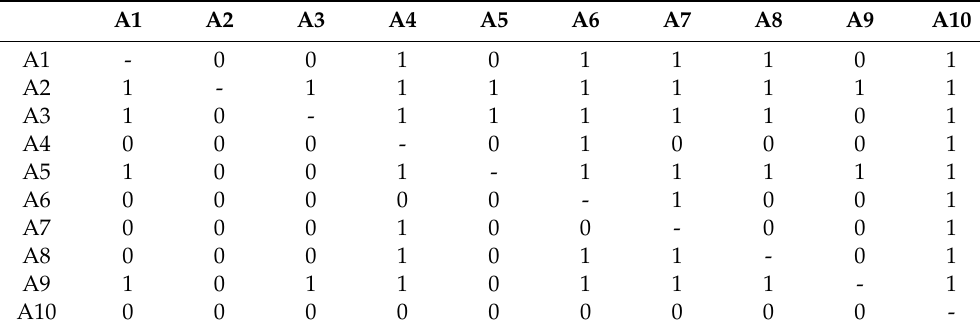
Table 24. Boolean matrix B based on the minimum concordance